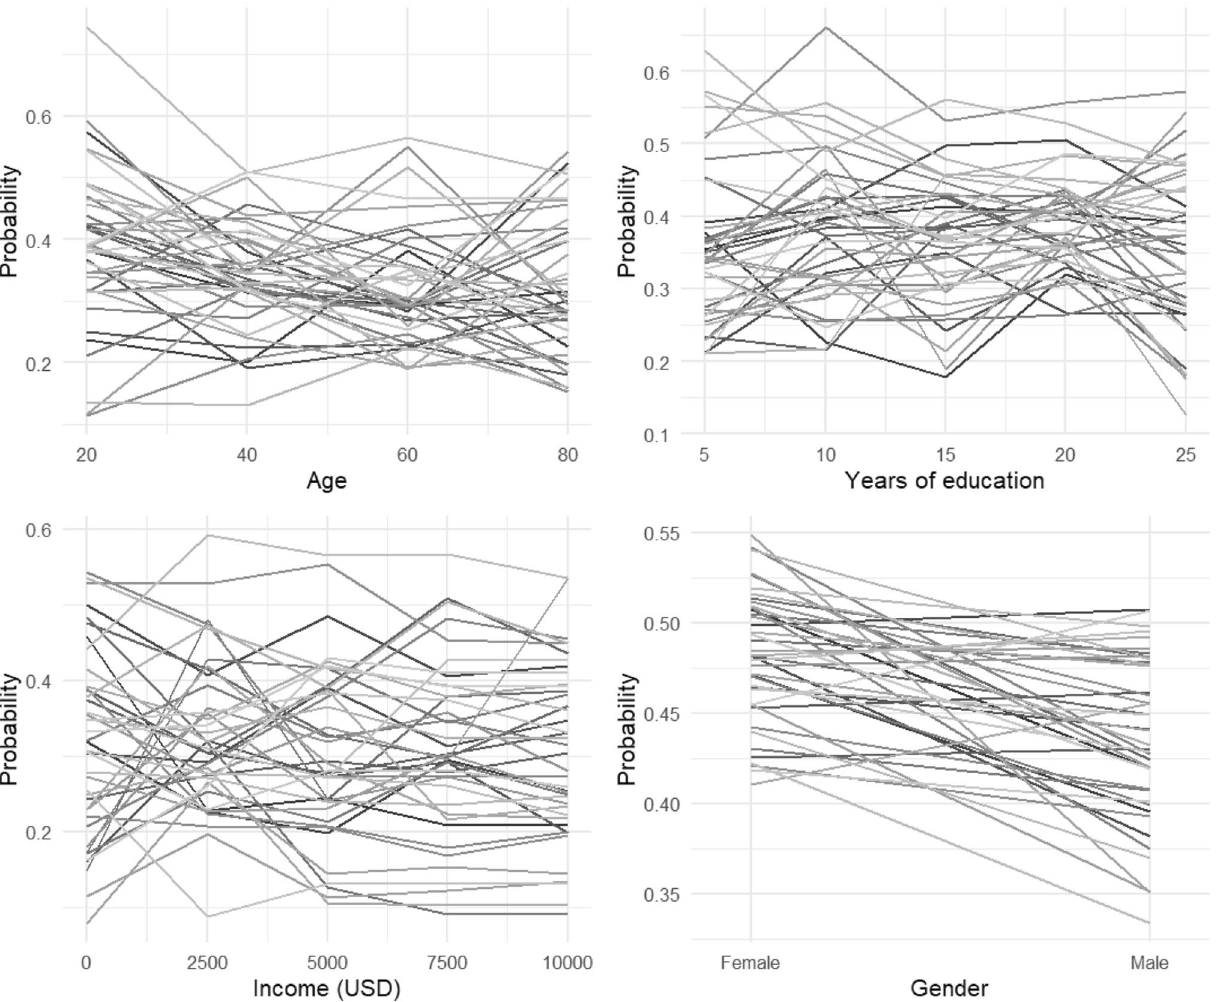
Figure 1. Partial dependence plots show the average predicted probability of attending social gatherings associated with a given value of the demographic factor of age, years of education, income, and gender (in different plots) for all the